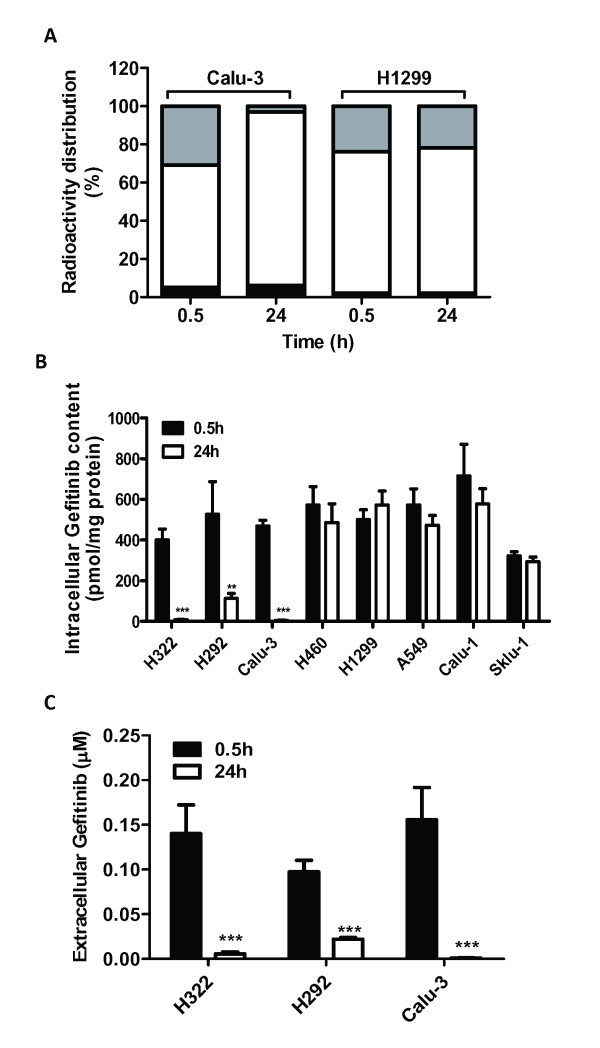
Intracellular and extracellular level of gefitinib in NSCLC cell lines. A) Radioactivity distribution in Calu-3 and H1299 cells incubated with 0.1 μM [3H]gefitinib for 0.5 h or 24 h. The amount of radioactivity was determined in intracellular (gray), extracellular (white) and intracellular macromolecule-linked (black) compartments. Values are given as percentage versus the total amount of radioactivity. B) Intracellular level and C) extracellular concentration of gefitinib in a panel of NSCLC cell lines evaluated by LC-MS/MS. Gefitinib-sensitive cell lines (H322, H292, Calu-3) and resistant-cell lines (H460, H1299, A549, Calu-1, SKLU-1) were incubated with 0.1 μM gefitinib for 0.5 h and 24 h. Values given are the means (± SD) of four independent determinations (**P < 0.01; ***P < 0.001).